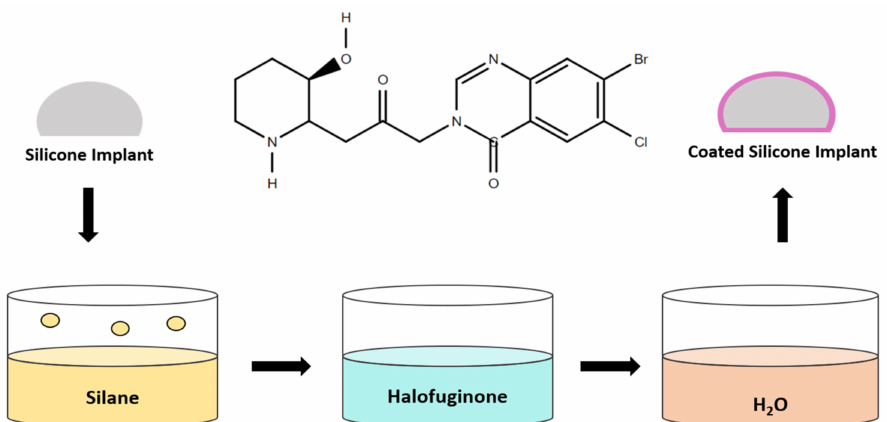
Figure 11. Dipping method for modification of silicone implants with Halofuginone. This is a simple method with a cost-effective approach. Halofuginone modified silicone implant significantly reduced the collagen I synthesis, which is crucial for fibrous capsule formation. Reproduced with permission from